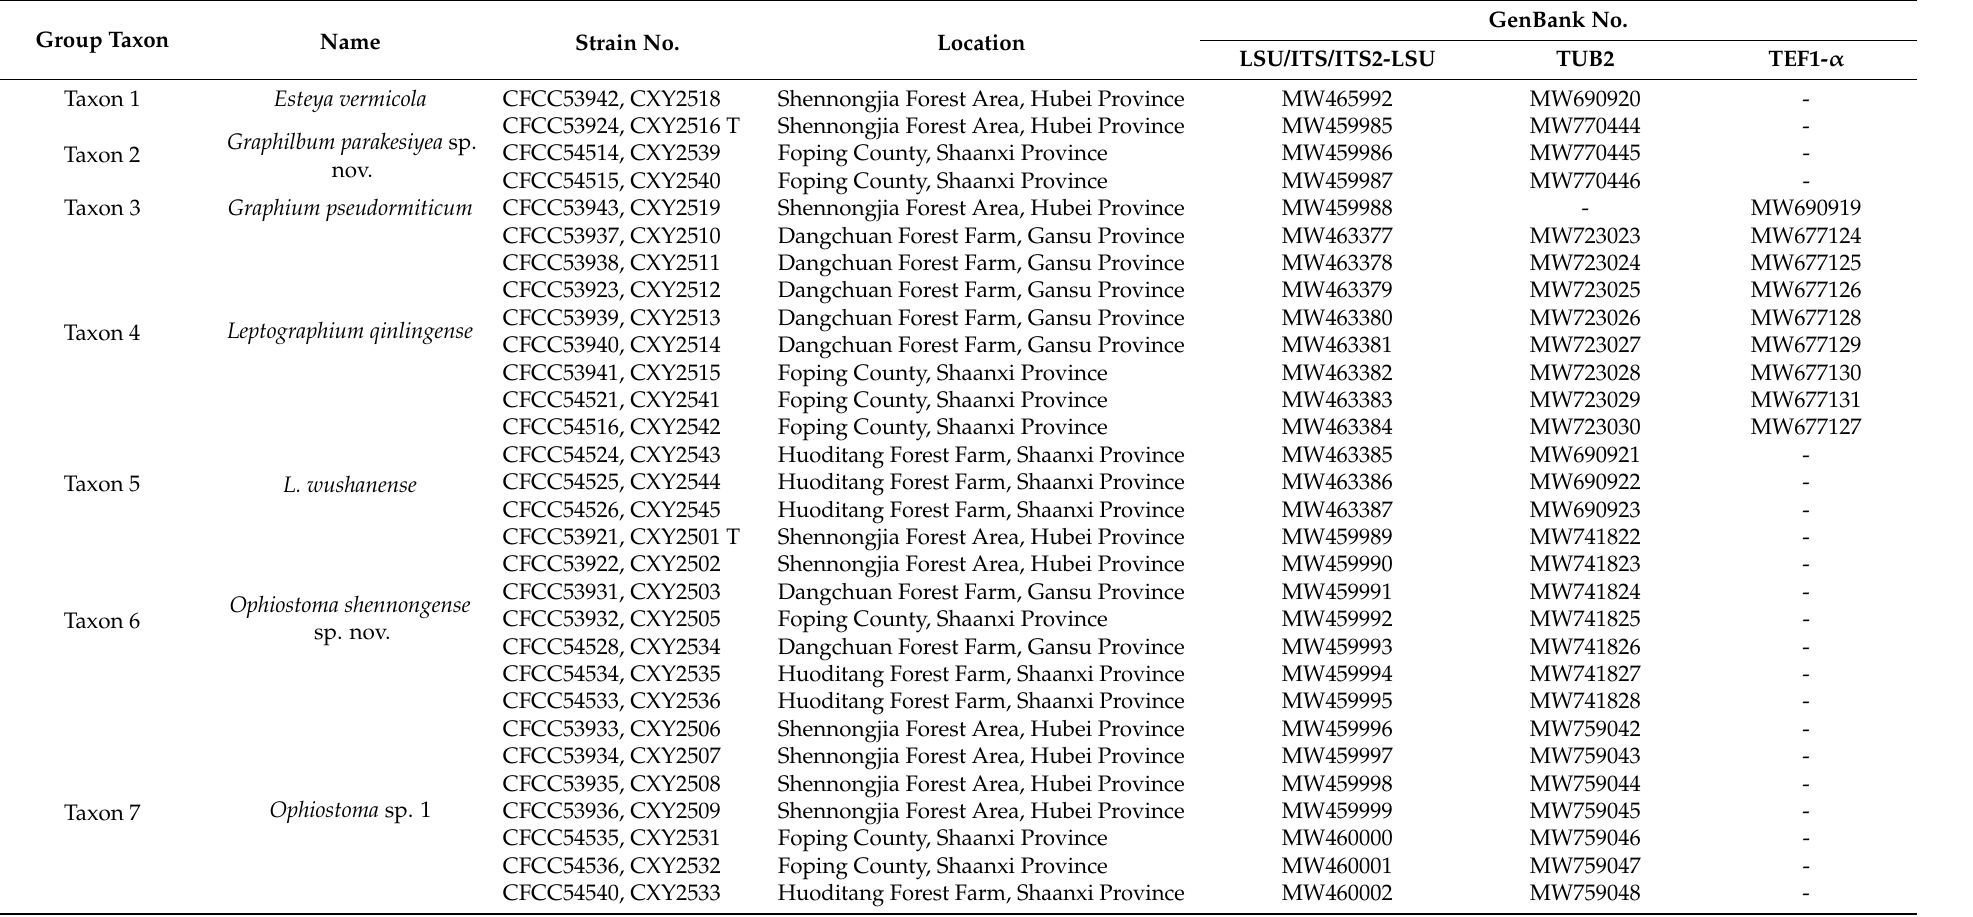
Table 2. Representative strains of the ophiostomatoid fungi associated with D. armandi used for morphological and phylogenetic analysis and pathogenicity trials in this